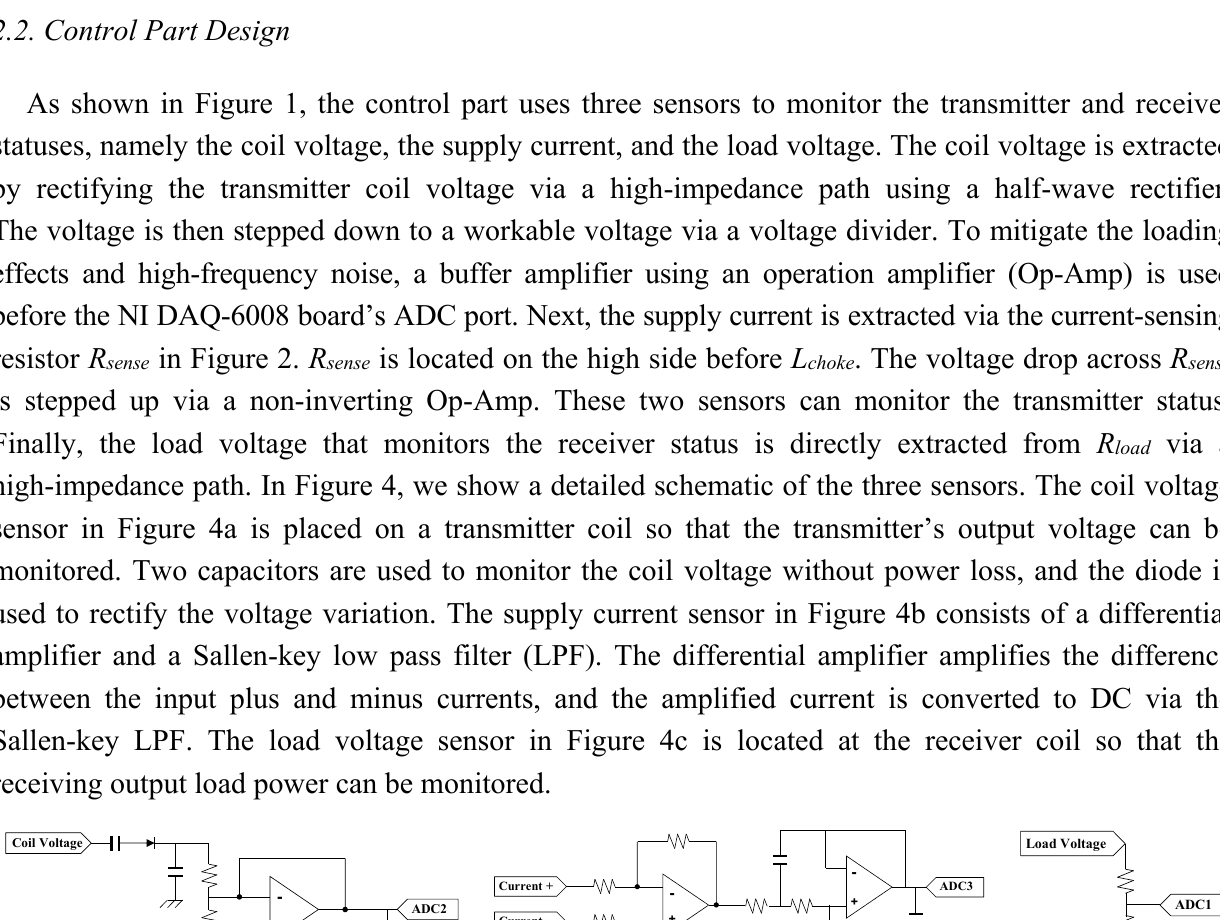
Figure 3. Measurement and simulation results as a function of R load . ( a ) Received power; ( b ) Efficiency.